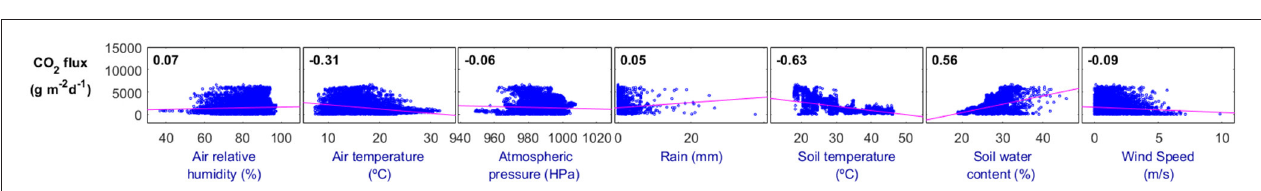
FIGURE 3 | Pearson correlation coefficients between soil CO 2 flux and the monitored environmental variables. Blue points correspond to the environmental variables vs. the soil CO 2 flux and the pink lines are the correlation